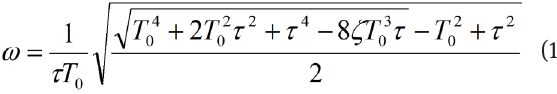
Figure 3: An example of SAS configuration; a) block diagram, 1 – acoustic-vibration transmitter; 2 – amplifier; 3 – conditioner; 4 – acoustic-vibration receiver; 5 – measurement and control block; 6 – monitored component; b) sensor configuration in the LabVIEW program